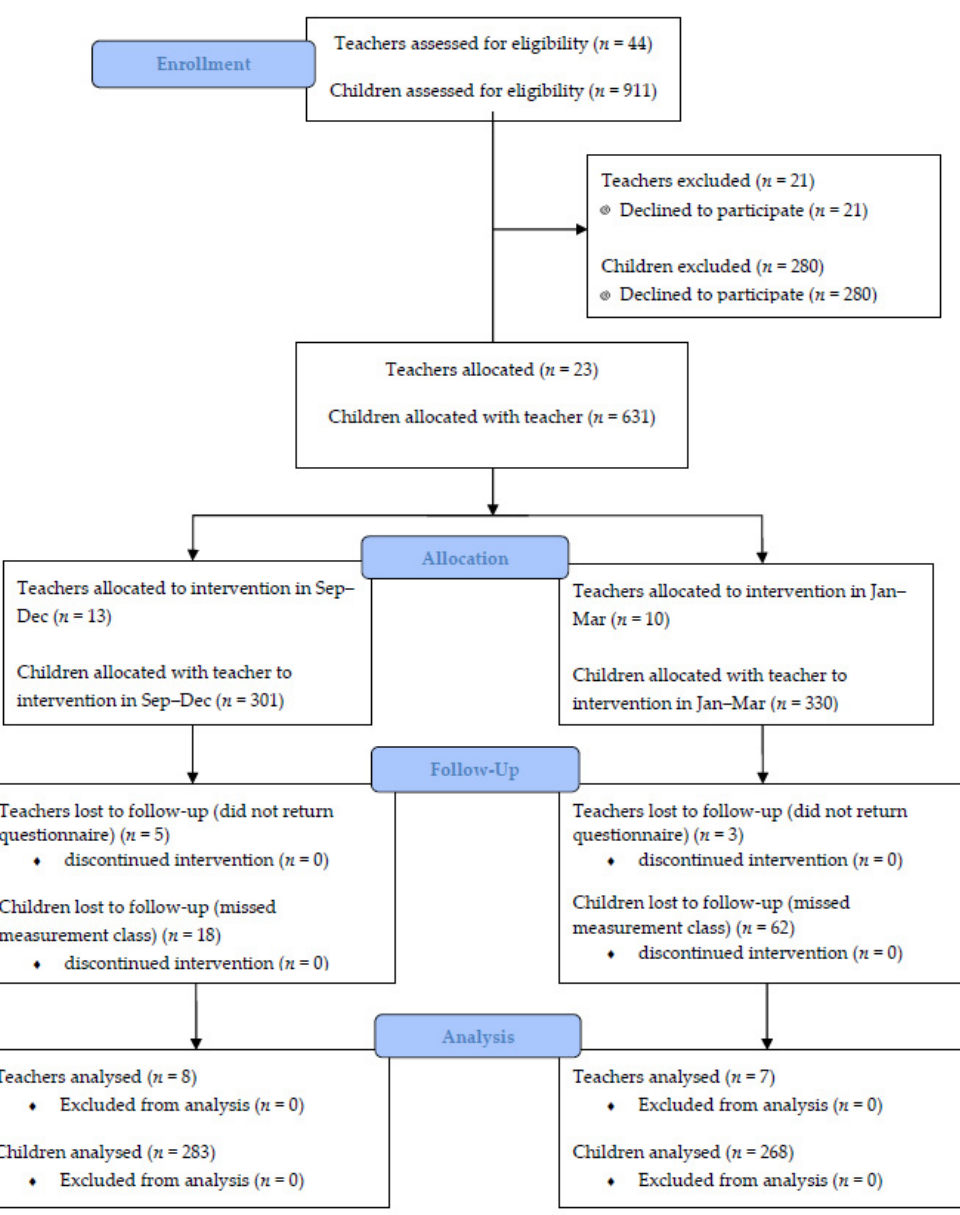
Figure 1. Consolidated Standards of Reporting Trials (CONSORT) table for process of teacher and child level recruitment, consent and analysis.